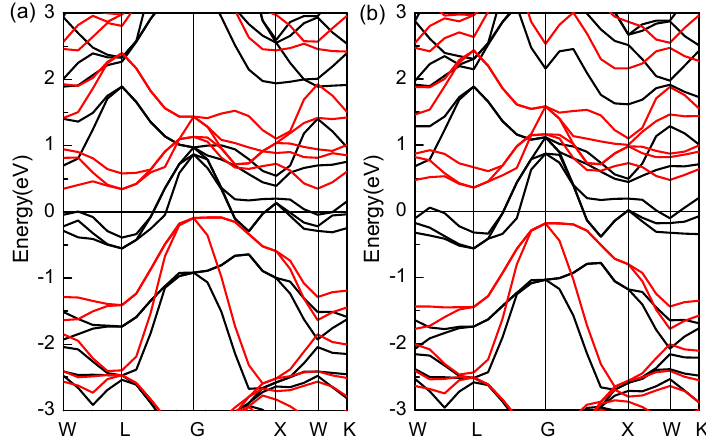
Figure 3. The calculated band structures for ZrRhTiAl ( a ) and ZrRhTiGa ( b ). (The black lines represent the spin-up channel, and the red lines the spin-down channel.). Table 1. The equilibrium lattice constants (Å), total magnetic moments ( µ B ), atomic magnetic moments ( µ B ), valence band maximum (eV), conduction band minimum (eV), band gap (eV), half-metallic (HM) band gap (eV), and the number of valence electrons for ZrRhTiZ (Z = Al, Ga) compounds. Compound ZrRhTiAl